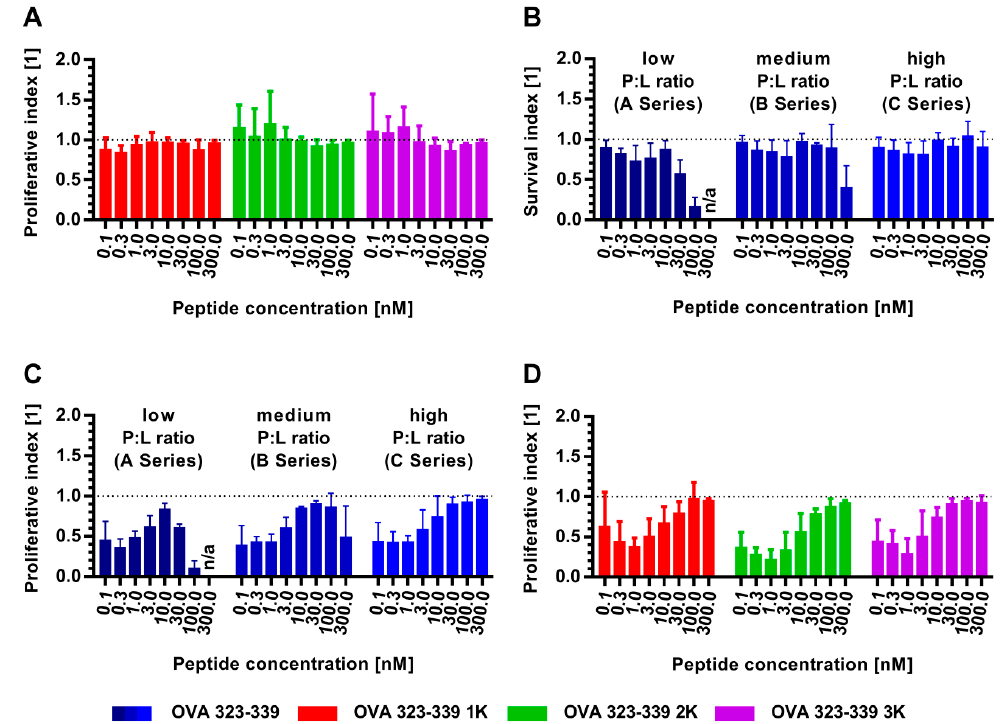
Figure 7. Co-culture of dendritic cells and antigen-specific CD4 + T cells in the presence of free (non-liposomal) or liposomal peptide. ( A ) Influence of bi-terminal sequence extension on the proliferation of antigen-specific CD4 + T cells. The results are presented as a proliferative index (% of proliferating CD4 + T cells cultivated with the bi-terminally extended peptide / % of proliferating CD4 + T cells cultivated with the unmodified peptide). ( B ) Influence of the peptide:lipid ratio of peptide-loaded liposomes on the viability of the antigen-specific CD4 + T cells. The results are presented as a survival index (% of viable CD4 + T cells cultivated with liposomal OVA 323-339 / % of viable CD4 + T cells cultivated with free OVA 323-339). Viability was determined by flow cytometry after staining with Fixable Viability Dye from Thermo Fisher Scientific (Figure S6). ( C ) Influence of the peptide:lipid ratio on the proliferation of antigen-specific CD4 + T cells. The results are presented as a proliferative index (% of proliferating CD4 + T cells cultivated with liposomal OVA 323-339 / % of proliferating CD4 + T cells cultivated with free OVA 323-339). ( D ) Differences in proliferation of antigen-specific CD4 + T cells in response to liposomal and free peptides. Peptide-loaded liposomes of the C series were used. The results are presented as a proliferative index (% of proliferating CD4 + T cells cultivated with liposomal peptide / % of proliferating CD4 + T cells cultivated with free peptide). ( B-D ) The peptide-loaded liposomes used in this set of in vitro experiments were composed of 45 mol% DSPC, 40 mol% cholesterol and 15 mol% DSPG. A comprehensive characterization of these liposomes is summarized in Table S8 and Table S9. ( A–D ) Data represent the mean ± standard deviation from three experiments.